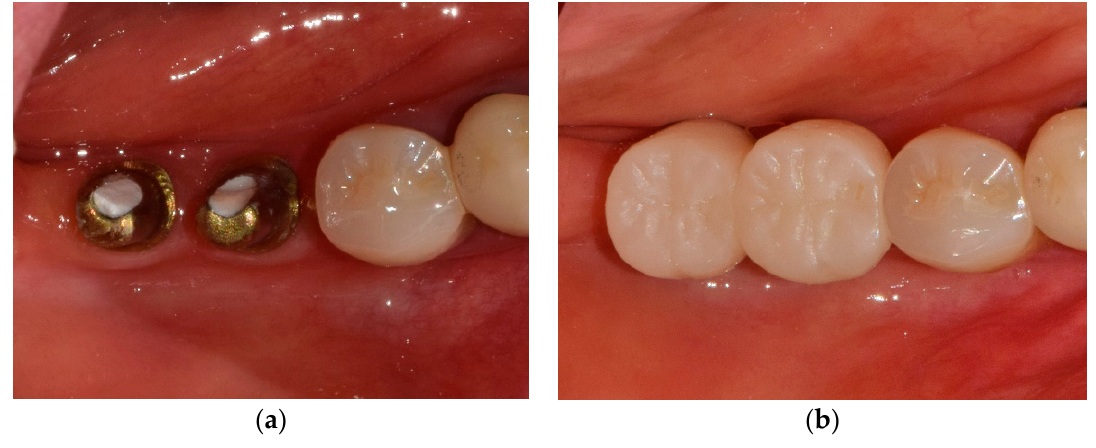
Figure 2. ( a ) Connection of the custom prosthetic abutments to the implants. ( b ) Cementation of the interim prosthesis on the abutments.